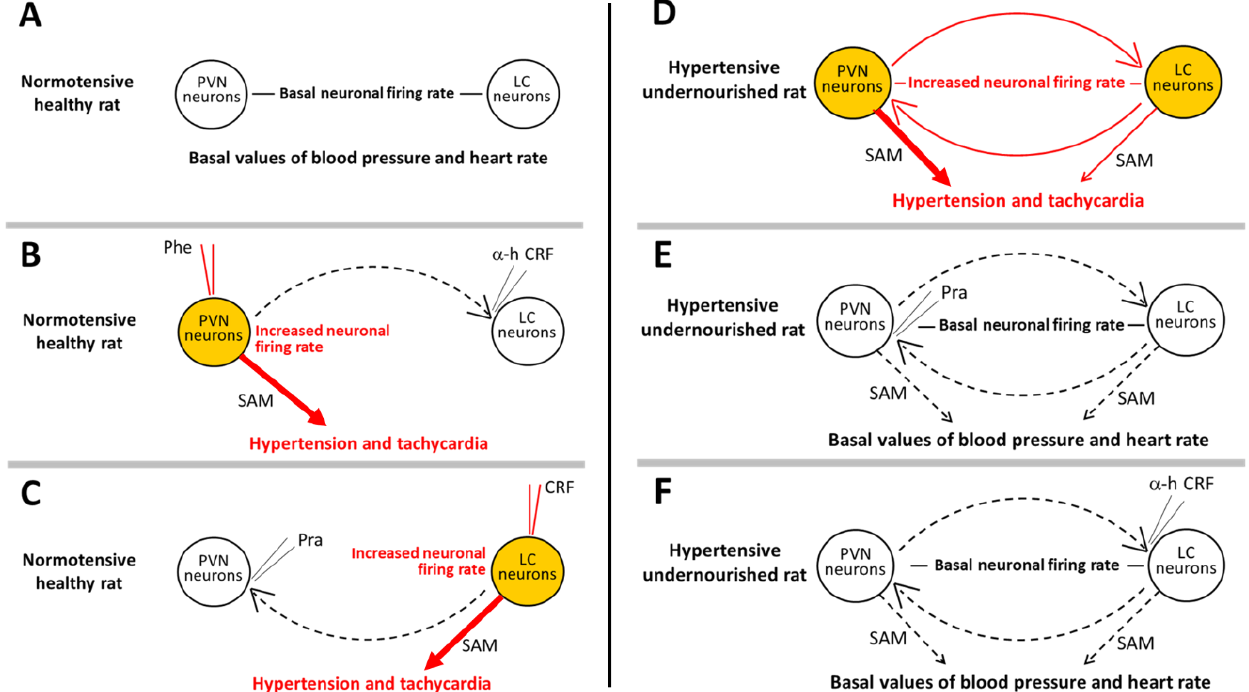
Figure 1. Reciprocal excitatory feedforward loop between CRFergic neurons of the PVN and nora- drenergic neurons of the LC, enabled in prenatally malnourished animals. Left panels ( A – C ) refer to the level of neuronal activity in PVN and LC as well as the levels of blood pressure and heart rate, in healthy normotensive rats: ( A ) at rest with no drugs (white color means basal neuronal activity in PVN and LC, along with normal basal blood pressure and heart rate), ( B ) after stimulation of PVN neurons with the α 1 -adrenoceptor agonist phenylephrine while blocking the PVN-LC com- munication with the CRF receptor antagonist α -helical CRF (orange color at PVN means increased neuronal activity and hypertension/tachycardia), ( C ) after stimulation of LC neurons with CRF while blocking the LC-PVN communication with the α 1 -adrenoceptor antagonist prazosin (orange color at LC means increased neuronal activity and hypertension/tachycardia). Right panels ( D – F ) refer to the level of neuronal activity in PVN and LC as well as the levels of blood pressure and heart rate, in undernourished hypertensive rats: ( D ) with no drugs (orange color at PVN and LC means increased neuronal activity in both nuclei, along with hypertension and tachycardia), ( E ) after blocking the LC-PVN communication at the PVN with the α 1 -adrenoceptor antagonist prazosin (white color at PVN and LC means basal neuronal activity in both nuclei, along with normal blood pressure), ( F ) after blocking the PVN-LC communication at the LC with the CRF receptor antagonist α -helical CRF (white color at PVN and LC means basal neuronal activity in both nuclei, along with normal blood pressure). PVN, paraventricular nucleus of the hypothalamus; LC, locus coeruleus; SAM, sympathetic-adrenal-medullary output system (thick arrows indicate larger output). Continuous red curved arrows indicate enabled communication between nuclei, and segmented black curved arrows indicate disrupted communication. Note red micropipettes for injecting the agonists, and grey micropipettes for injecting the antagonists. Overall, agonists produce increased neuronal firing rate in normotensive healthy animals leading to hypertension and tachycardia, the antago- nists in the complementary nuclei preventing the excitation there and the cardiovascular effects. In hypertensive undernourished animals, any of the two antagonists turn off the increased neuronal firing rate showing these animals both in the PVN and LC, thus normalizing the blood pressure and heart rate. Importantly, the reciprocal excitatory feedback loop between PVN and LC neurons in prenatally malnourished adult rats is certainly more complex when considering the local regulatory neuronal circuits in these nuclei, which include some well-characterized modulatory interneurons. In fact, in the PVN, together with the direct α 1 -adrenoceptor- mediated excitatory noradrenergic input to CRF-expressing parvocellular neurons [128- 132], there are GABA-synthesizing interneurons that inhibit PVN neuronal activity [133]. The noradrenergic input to the PVN has been shown to inhibit PVN-surrounding GA-